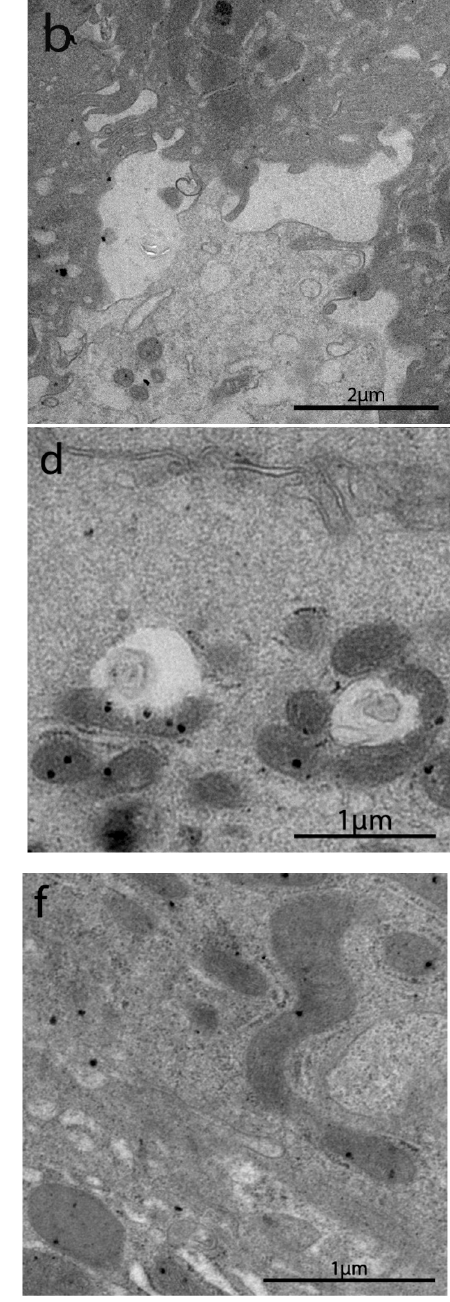
Figure 4. TEM images of autophagic bodies and lysosomal vacuoles in the cytoplasm of enterocytes in IBS-like disorders. Legend: uCD ( a ), tCD ( b ), WA ( c ), NCGS ( d ), Ni ACM ( e ), CTRL ( f ). All pictures ( a – e ) showed increased autophagic bodies, as well as lysosomal vacuoles in the apical cy- toplasm, whereas no signs of autophagy have been observed in controls ( f ).